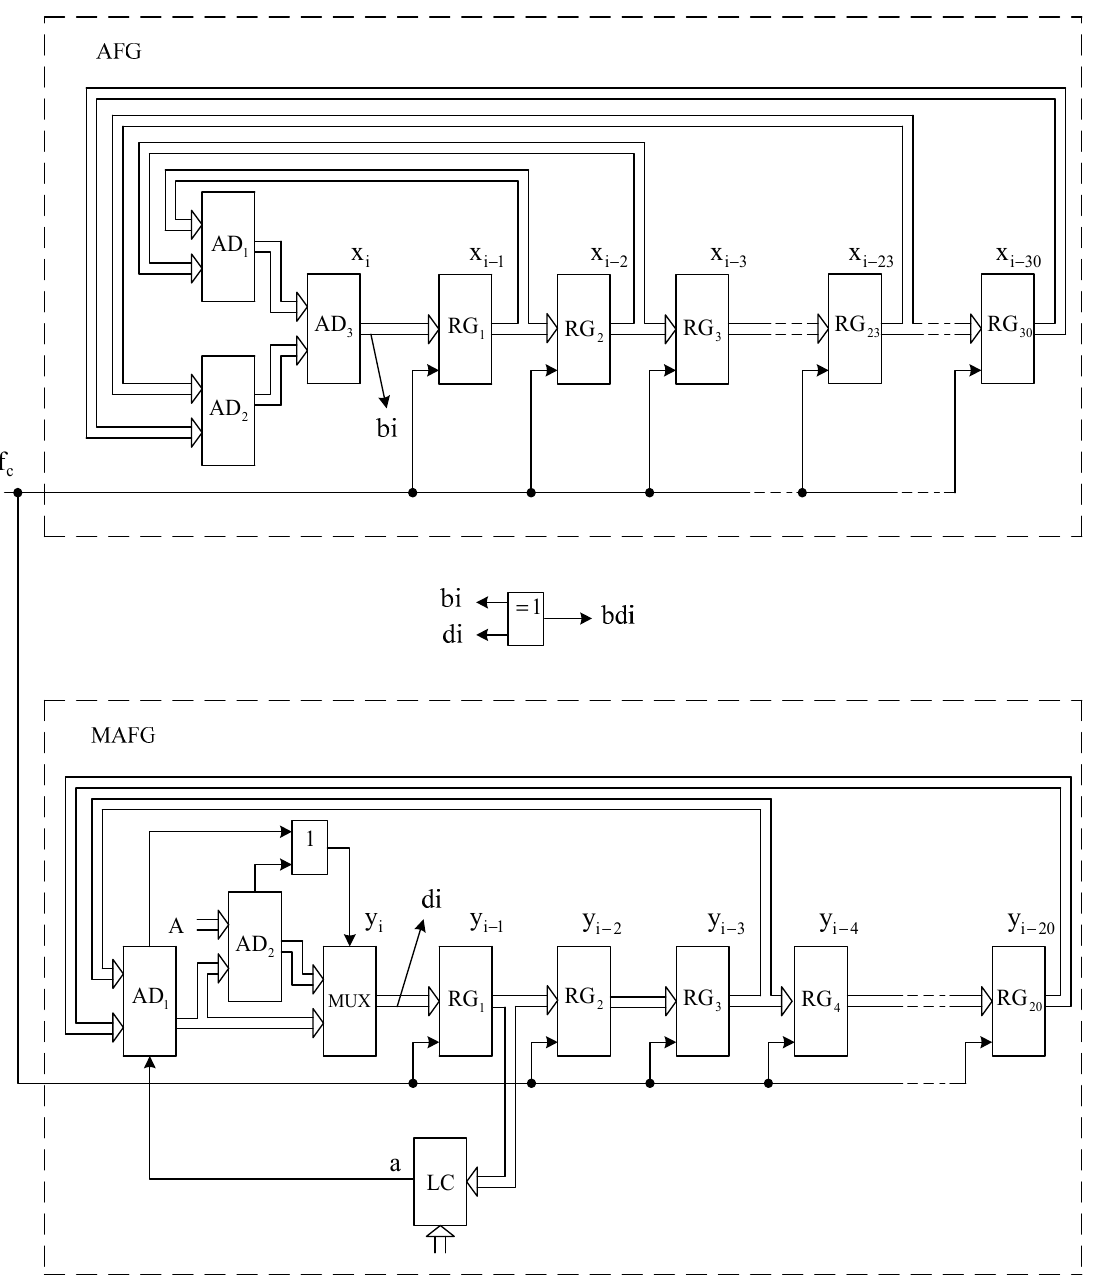
Figure 2. Structure scheme of the joint work of AFG and MAFG.